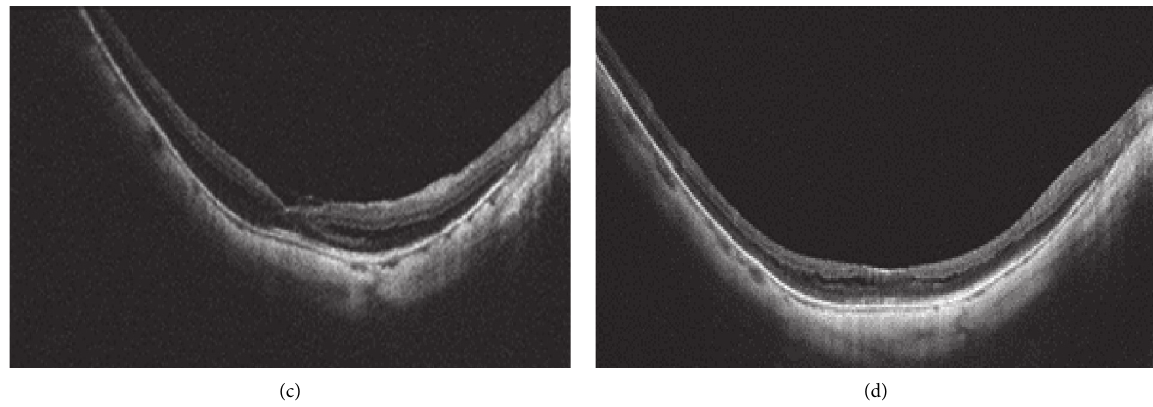
Figure 4: Pre and postoperative representative OCTimages of myopic foveoschisis accompanied by the lamellar macular hole. Preoperative image shows a foveoschisis, lamellar macular hole (red arrow), and posterior vitreous detachment (blue arrow). The CFTand BCVA were 505 μ m and 0.7, respectively (a). At 1 month after operation, the foveal schisis was fully reattached (red arrow), but parafoveal schisis still remained (yellow arrow). The CFT was 323 μ m (b). At 3 months after operation, the parafoveal schisis was gradually resolved, and the CFT was 304 μ m (c). At six months after operation, parafoveal schisis and foveoschisis were completely resolved, and the CFT and BCVA were 290 μ m and 0.15, respectively